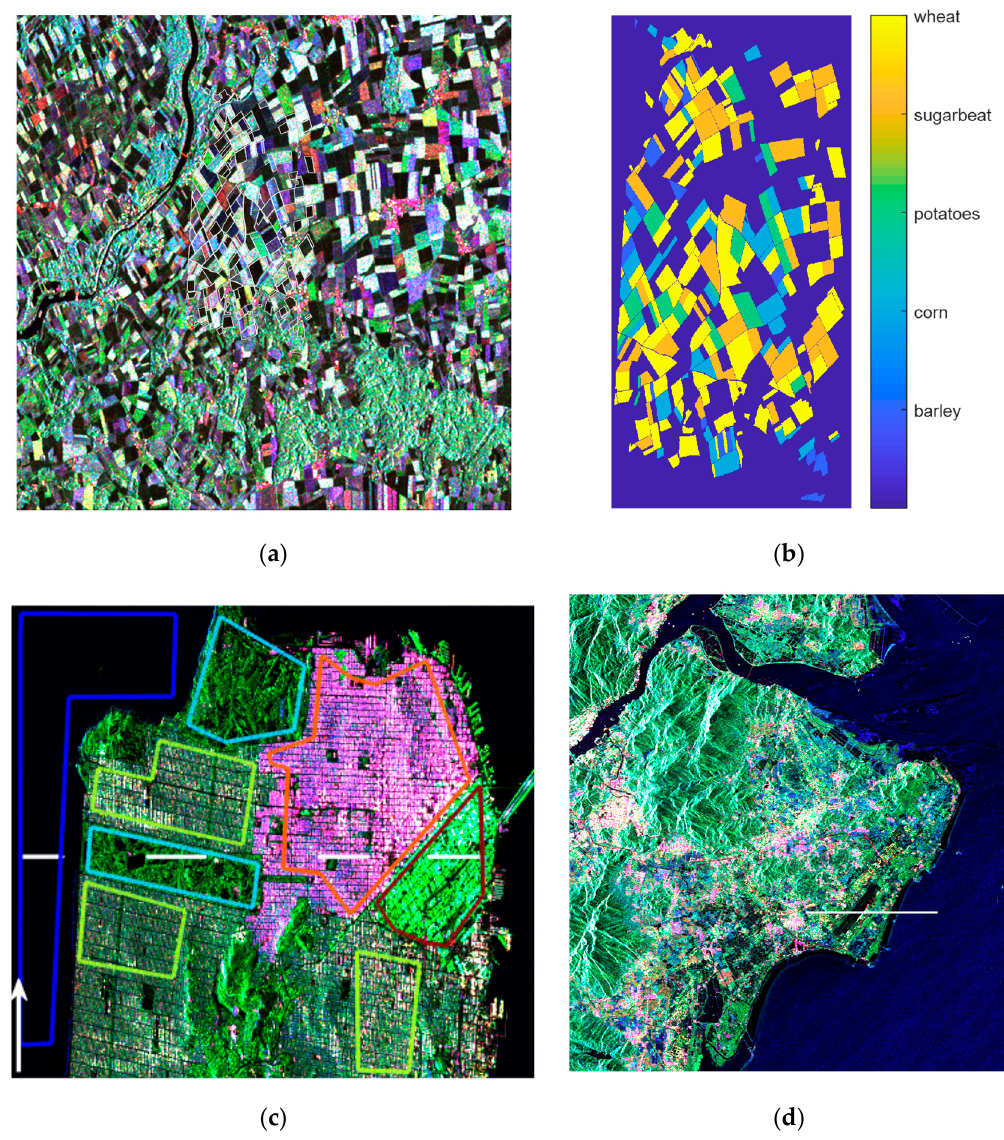
Figure 2. Pauli-basis images. ( a ) The Wallerfing data (28 May 2014), RADARSAT-2. ( b ) The crop type information of the Wallerfing area. ( c ) The San Francisco data, ALOS-2/PALSAR. Areas outlined by green, orange, and dark red are denoted as urban 1, urban 2, and tilted urban areas. ( d ) The Fuzhou data, RADARSAT-2.